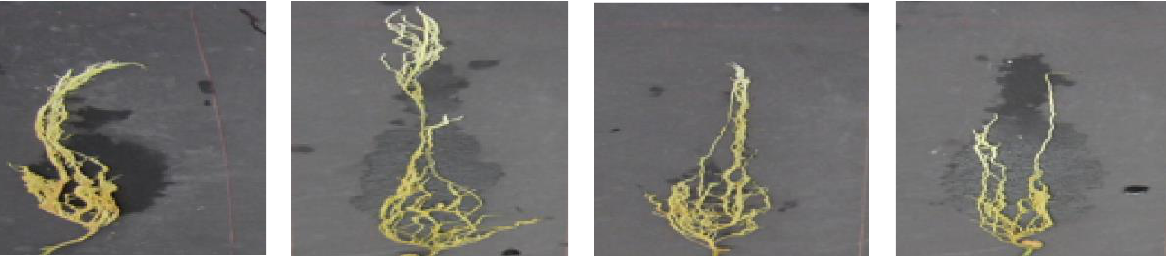
Figure 7. Sample artificial images synthesized by the GAN-generator model.